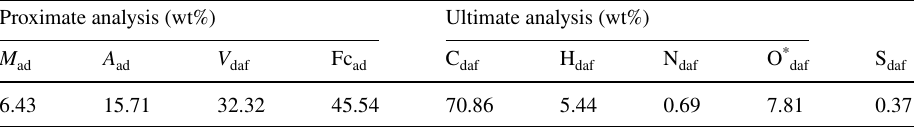
daf is a dry ash-free base, * is calculated from the